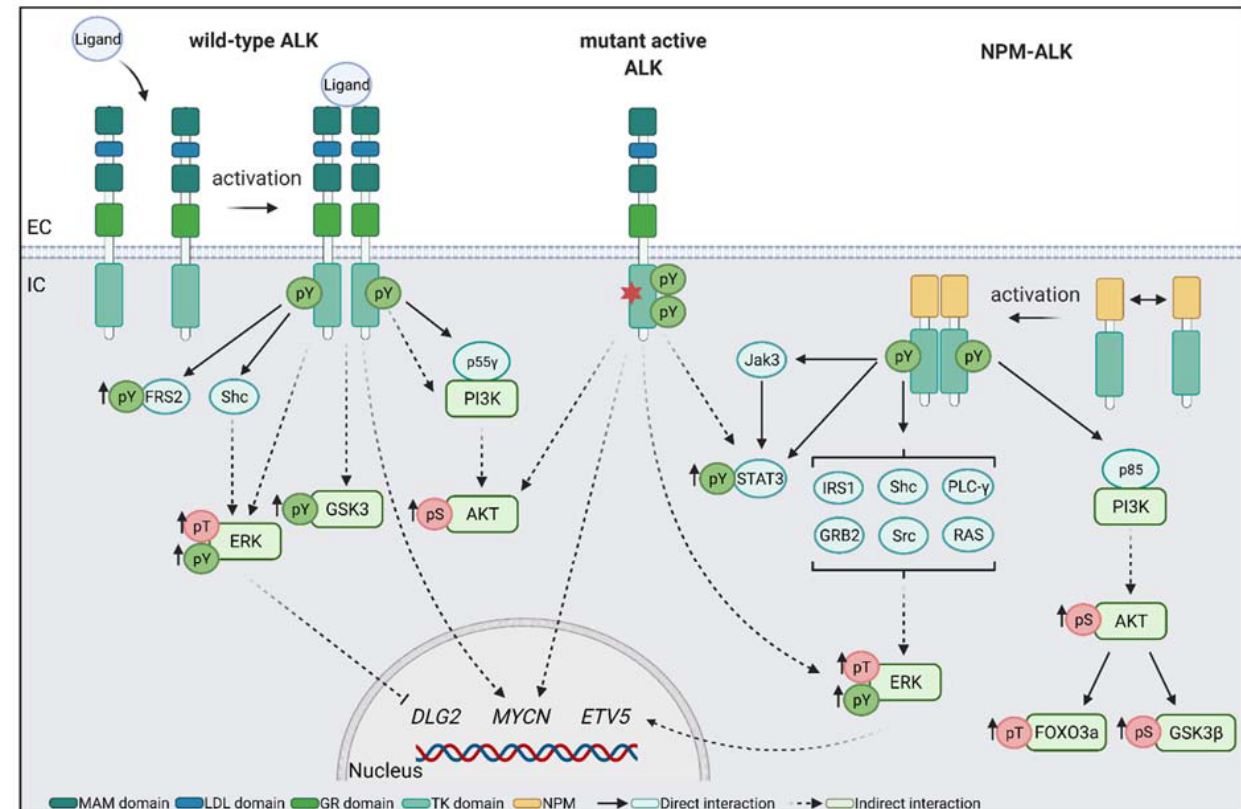
Figure 2. Downstream signalling of wild-type ALK, mutant active ALK, and NPM–ALK. Wild-type ALK activation is dependent on ligand binding, leading to activation and transphosphorylation of tyrosine residues in the tyrosine kinase (TK) domain. Phosphorylated tyrosines (pY) can function as docking sites for downstream targets, e.g., Shc and p55 γ . p55 γ is a regulatory subunit of PI3K and its activation leads to increased phosphorylation of AKT. Binding of Shc to pY-ALK leads to activation of the MAPK/ERK pathway and increased phosphorylation of ERK1/2. Both pathways are used as readouts of ALK activity. Mutations in the ALK tyrosine kinase domain can lead to constitutively active ALK independent of ligand binding. In neuroblastoma cells, mutated ALK may lead to increased STAT3 phosphorylation. In addition, in neuroblastoma cell lines with elevated active ALK, increased levels of phospho-tyrosine GSK3 have been shown. NPM–ALK fusions are found in anaplastic large cell lymphoma. NPM–ALK activity is dependent on the dimerisation of the fusion protein NPM. Similar to wild-type ALK, dimerisation leads to auto-phosphorylation of the tyrosine kinase domain. IRS1, Shc, PLC- γ , GBR2, and RAS have been shown to directly bind to NPM–ALK, which leads to activation of the MAPK/ERK pathway. In addition, NPM–ALK has been shown to directly bind and phosphorylate STAT3. In contrast to wild-type ALK, NPM–ALK has been shown to favourably bind to p85, a regulatory subunit of PI3K, and thereby activate the PI3K/AKT pathway. In addition, NPM–ALK has been shown to directly bind to insulin receptor